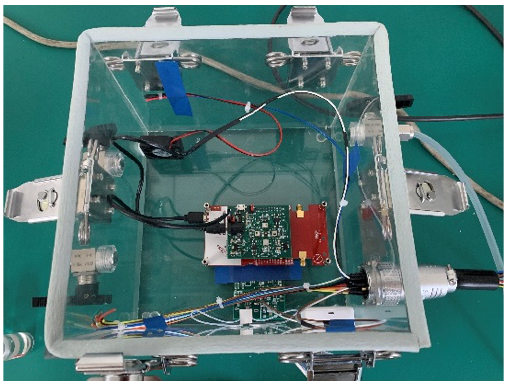
Figure 7. Gas chamber with sensor arrays and control board.